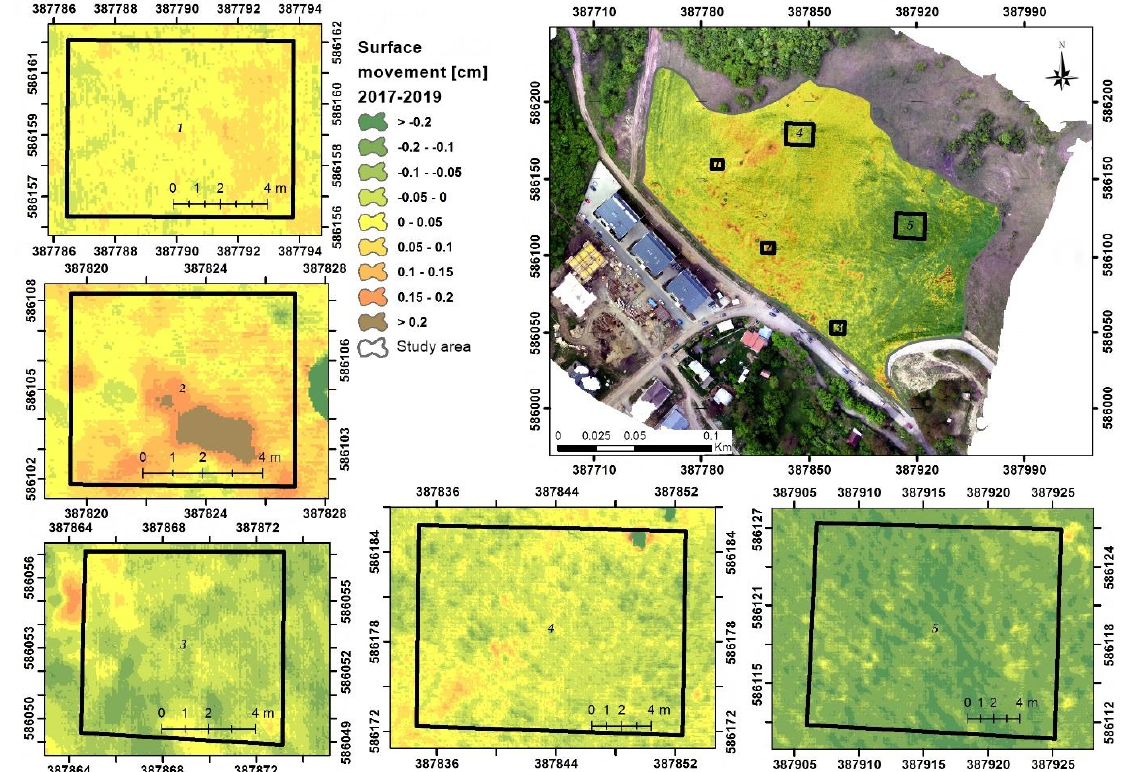
Figure 14. Rate of surface movement with the five plots highlighted.